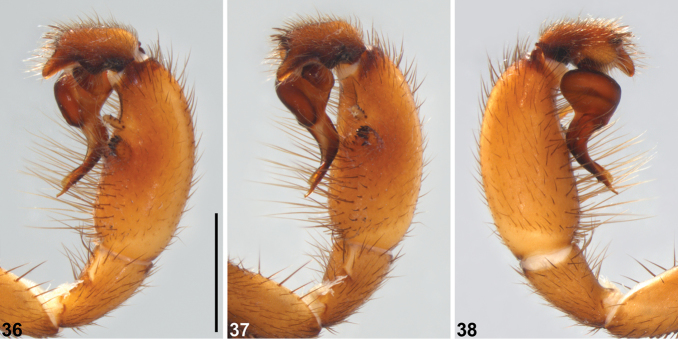

Idiosoma
nigrum Main, 1952, male (WAM T3301) from Walk Walkin, via Koorda (Western Australia; AVW), pedipalp. 36 Retrolateral view 37 Retroventral view 38 Prolateral view. Scale bar 2.0.